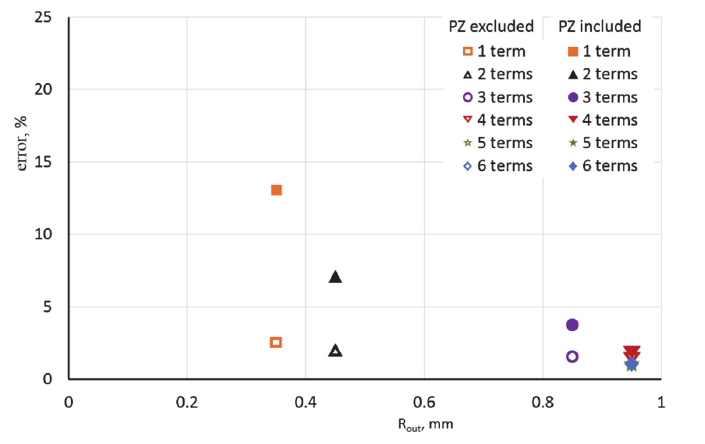
Figure 5: Effect of including or excluding the plastic zone in the collected data, i.e. setting R int =0 or setting R int =330 µ m .